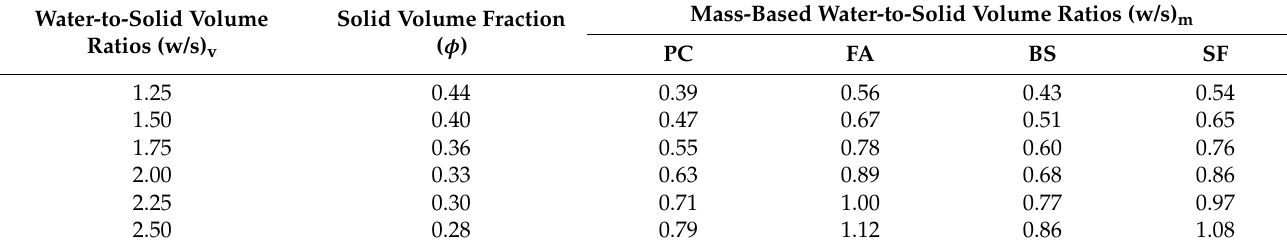
Table 3. Mix ratios of the cementitious